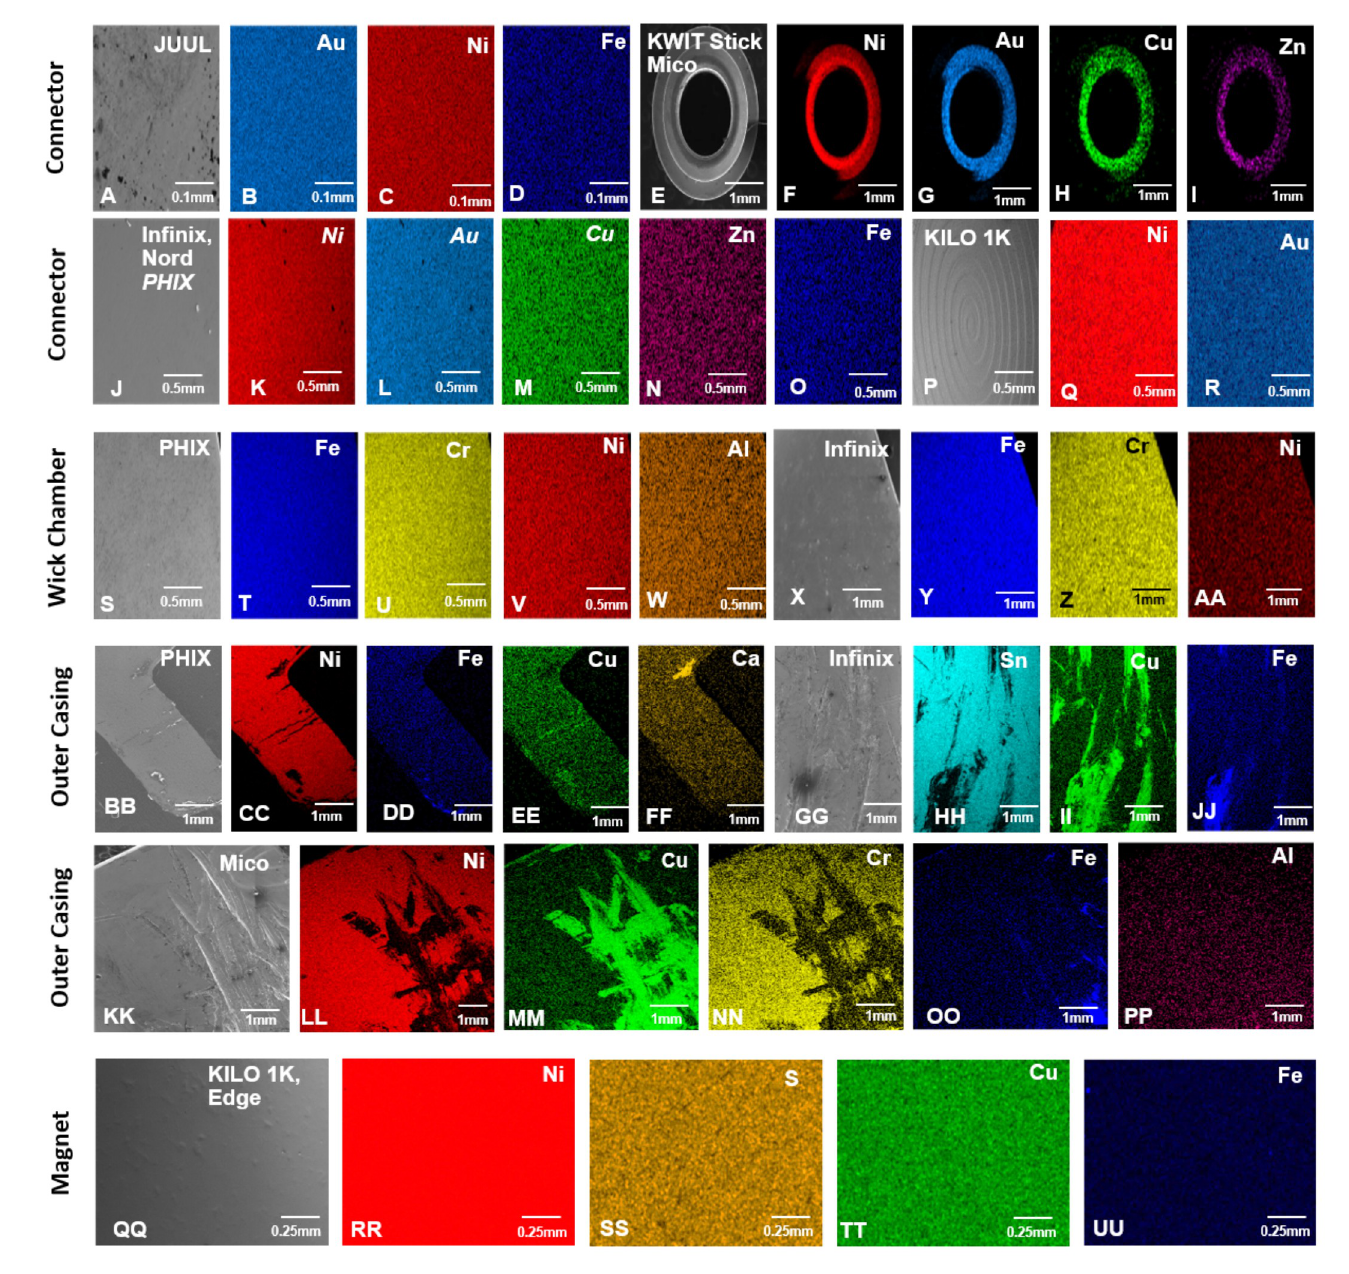
Fig 6. SEM images and EDS elemental maps of miscellaneous components from pod EC atomizers. Connectors present in JUUL ™ (A) were made of gold (B), nickel (C), and iron (D). KWIT Stick and SMOK Mico (E) were made of nickel (F), gold (G), copper (H), and zinc (I). SMOK Infinix, SMOK NORD, and PHIX (J) were made of nickel (K), gold (L), copper (M), zinc (N), and iron (O). Kilo 1K (P) was made of nickel (Q) and gold (R). Wick chambers present in PHIX (S) was made of iron (T), chromium (U), nickel (V), and aluminum (W). SMOK Infinix (X) was made of iron (Y), chromium (Z), and nickel (AA). The outer casing present in PHIX (BB) was made of nickel (CC), iron (DD), copper (EE), and calcium (FF). SMOK Infinix (GG) was made of tin (HH), copper (II), and iron (JJ). SMOK Mico (KK) was made of nickel (LL), copper (MM), chromium (NN), iron (OO), and aluminum (PP). Magnet components present in Kilo 1K and Suorin Edge (QQ) were made of nickel (RR), sulfur (SS), copper (TT), and iron